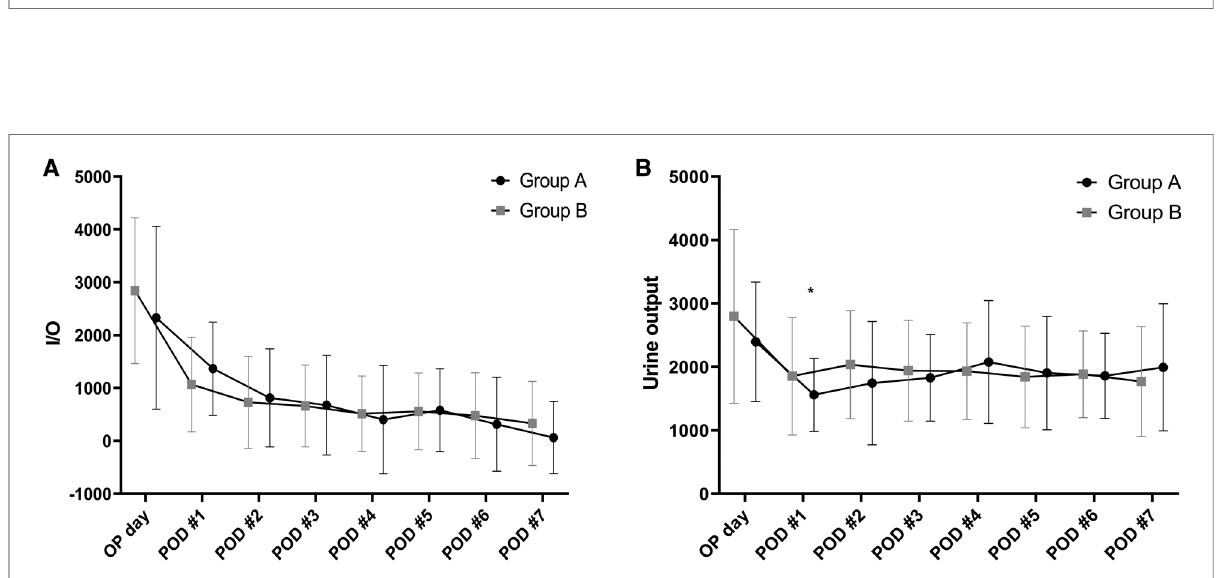
FIGURE 4 Between-group differences in laboratory results in the perioperative period. Creatinine ( A ). TB ( B ). INR ( C ). Albumin ( D ). Creatinine is signi fi cantly higher after postoperative day 1 to day 7in the patients with LVDD than in those with Normal LV diastolic function. * P <0.05 TB, total bilirubin; INR, international normalized ratio; LVDD, left ventricular diastolic dysfunction; LV, left ventricular.